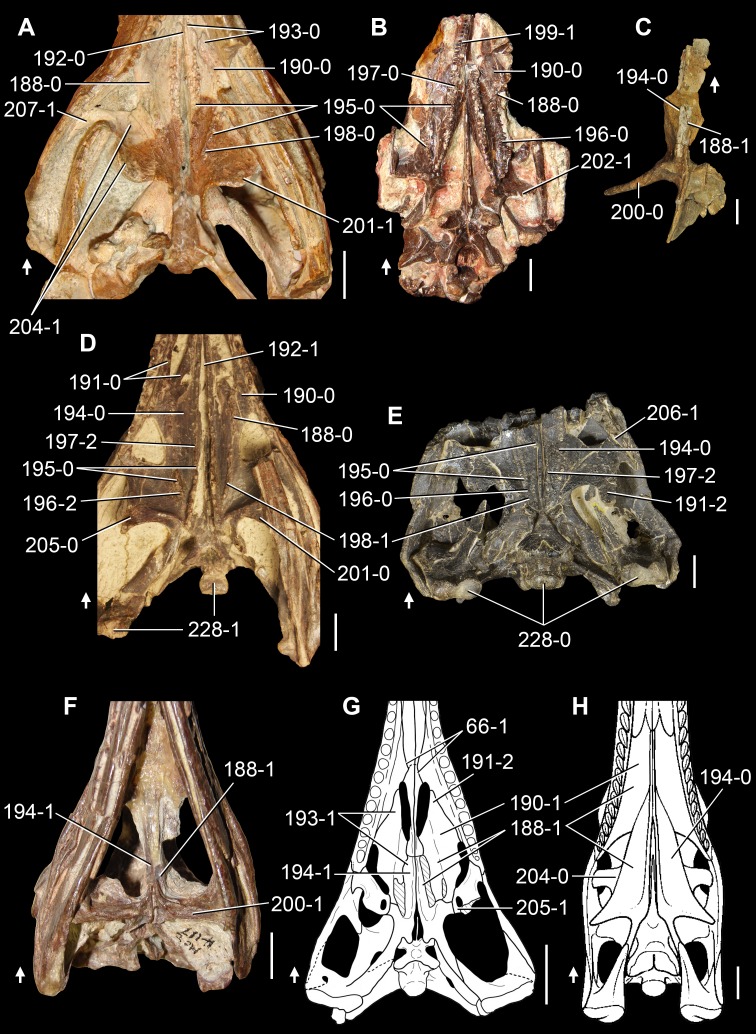
Skulls (A, B, D–H) and isolated pterygoid (C) of Permo-Triassic archosauromorphs in ventral view.(A) Mesosuchus browni (SAM-PK-6536); (B) Prolacerta broomi (BP/1/5066); (C) Erythrosuchus africanus (NHMUK PV R3592); (D) Chanaresuchus bonapartei (PVL 4586); (E) Doswellia kaltenbachi (USNM 214823); (F) Gracilisuchus stipanicicorum (MCZ 4117); (G) Parasuchus angustifrons; and (H) Herrerasaurus ischigualastensis. Numbers indicate character-states scored in the data matrix and the arrows indicate anterior direction. Scale bars equal 1 cm in (A, D–F), 5 mm in (B), 5 cm in (C, G), and 2 cm in (H). (G) Modified from Butler et al. (2014b) and (H) modified from Sereno & Novas (1994).